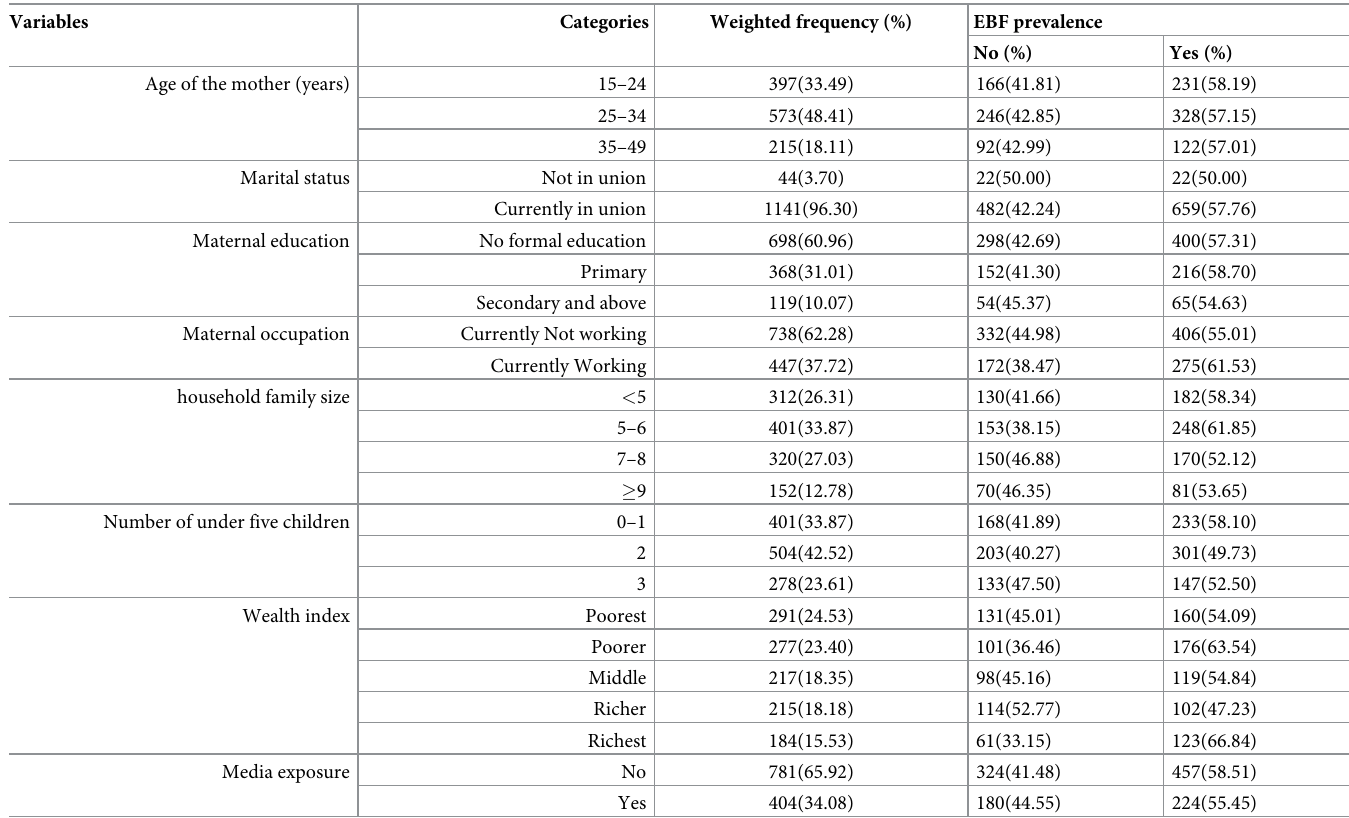
Table 2. Maternal socio-demographic and socioeconomic characteristics in Ethiopia, 2016 (n = 1185).